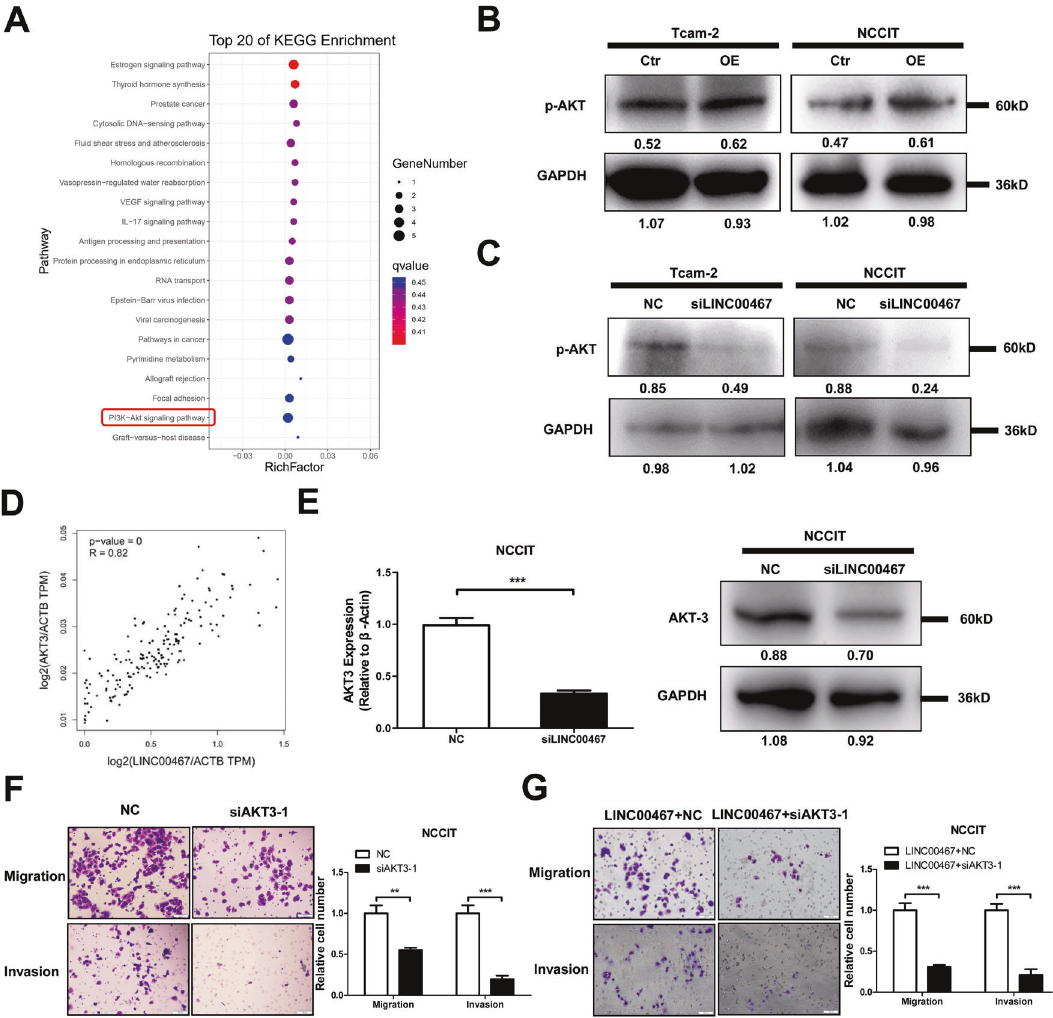
Fig. 6 LINC00467 regulates AKT3-dependent AKT phosphorylation to promote the migration and invasion abilities of TGCT cells. A KEGG enrichment analysis of the genes co-expressed with LNC00467 in the Meturquoise module is shown in Fig. 4B. B , C Western blotting analysis of the change in the p-AKT level after the overexpression of LNC00467 ( B ) and LINC00467 silencing ( C ). D Data from the GEPIA database were used to determine the correlation between LINC00467 expression and AKT3 expression. E qRT-PCR and western blotting were used to determine the mRNA and protein levels of AKT3 after LINC00467 silencing. F Transwell cell migration and invasion assays were used to determine the effect of silencing on the migration and invasion abilities of TGCT cells. G Transwell cell migration and invasion assays